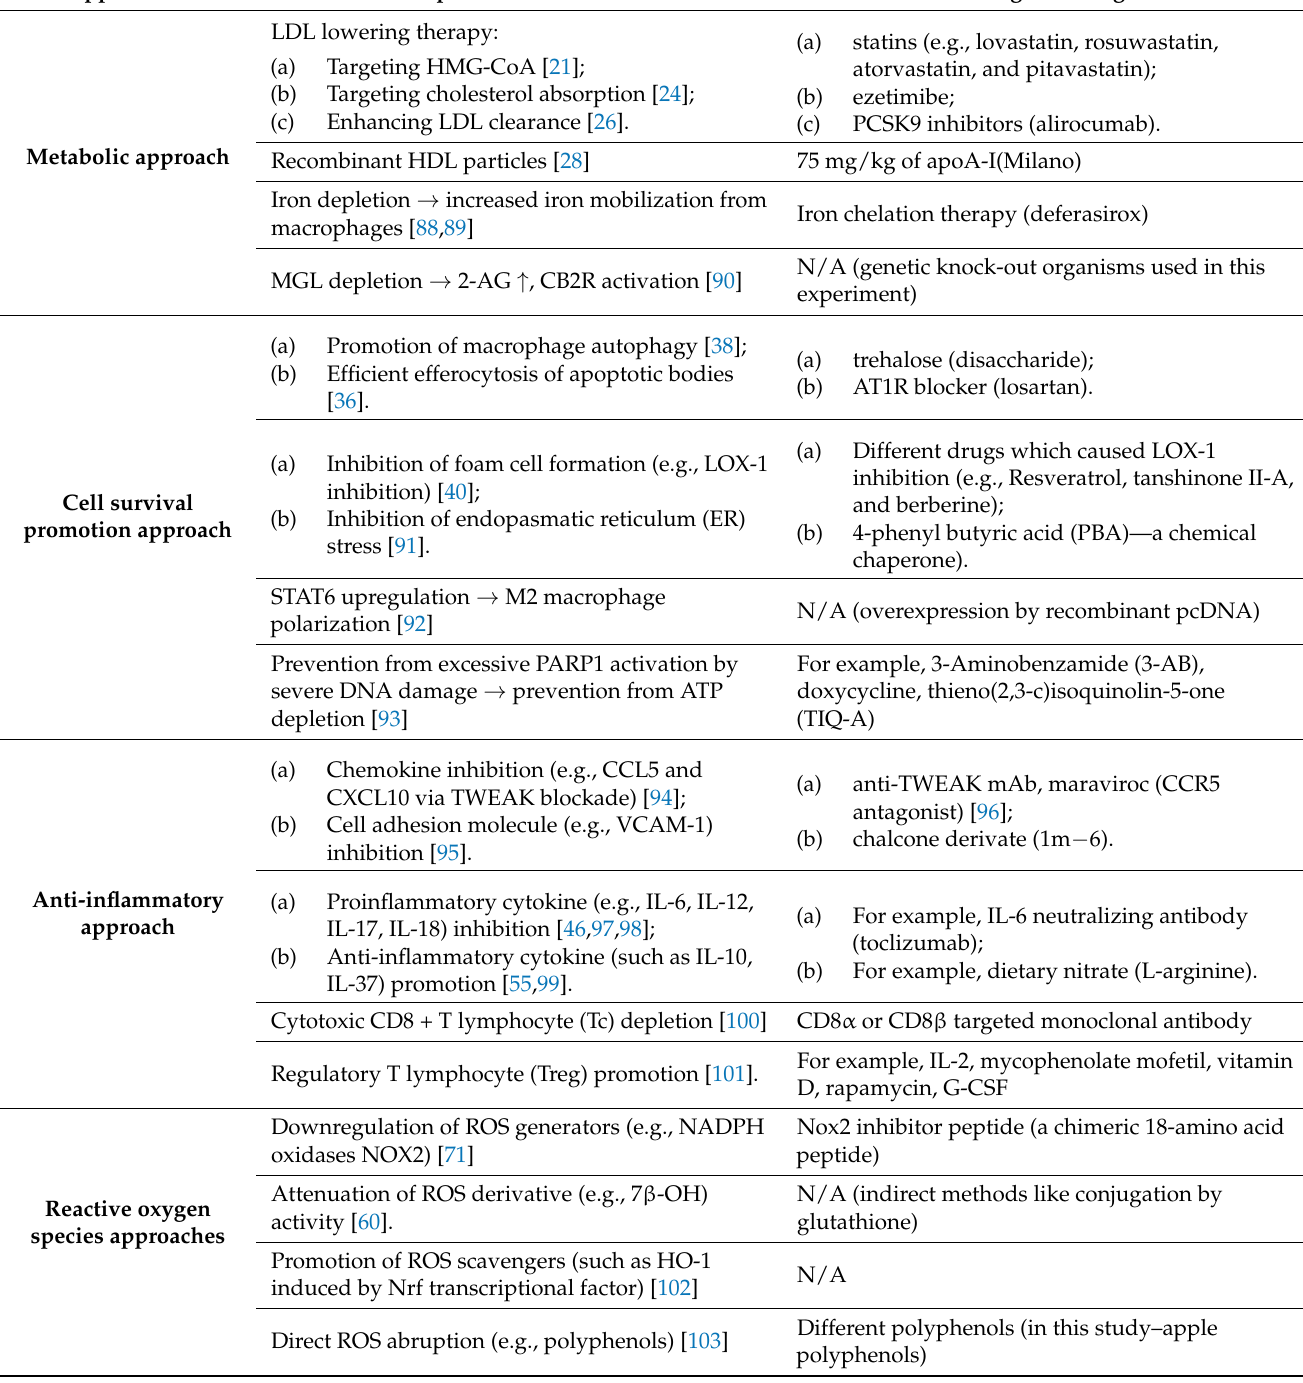
Table 1. Examples of atherosclerotic plaque stabilization treatment (five main approaches) in preclinical models and used drugs. Approaches Examples and